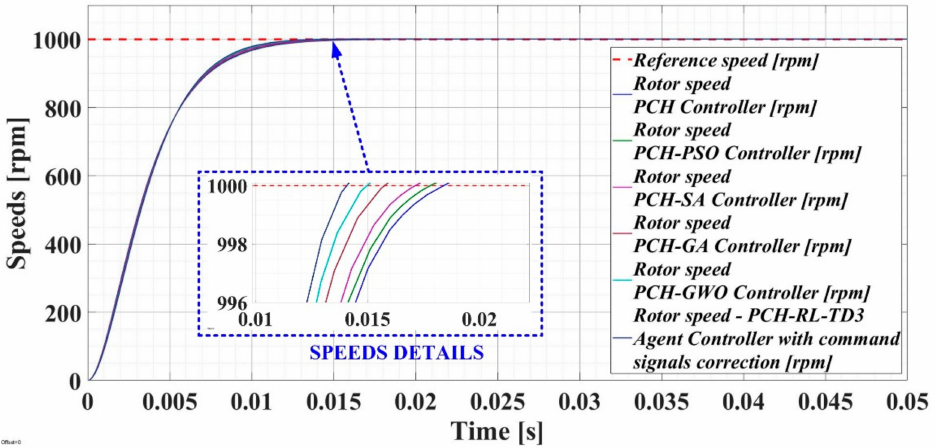
Figure 23. Comparison of the time evolution of speed for PMSM–CS–CI based on the PCH-type controller. Based on these comparative indicators, the PMSM–CS–CI performance is presented in Table 1. Table 1. Performance of the proposed control structures of the